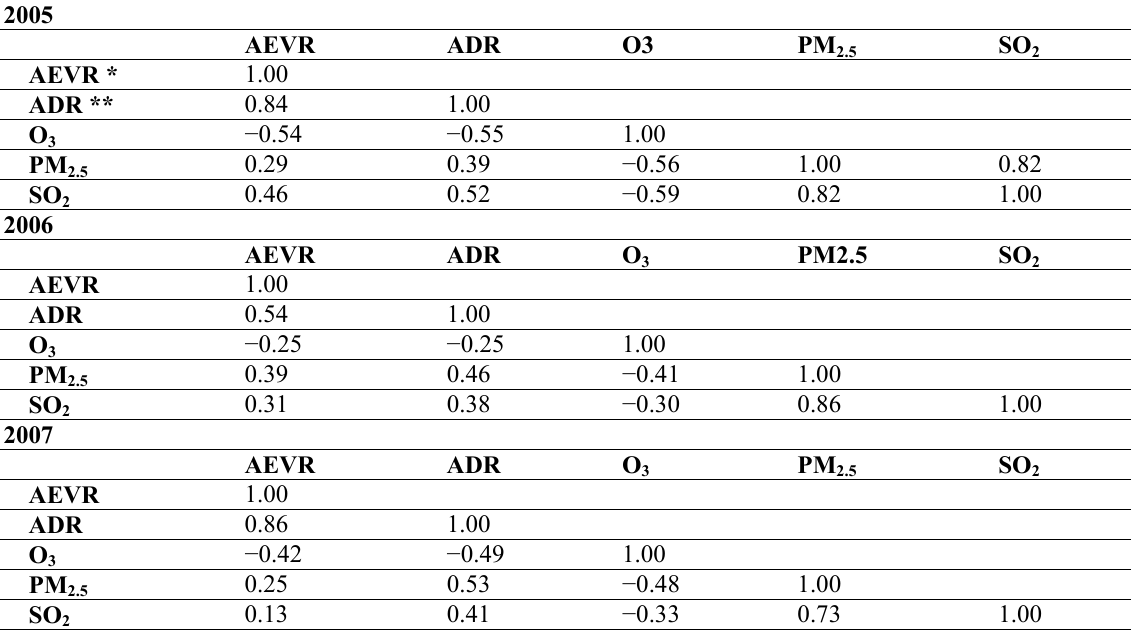
Table 3. Map Correlation